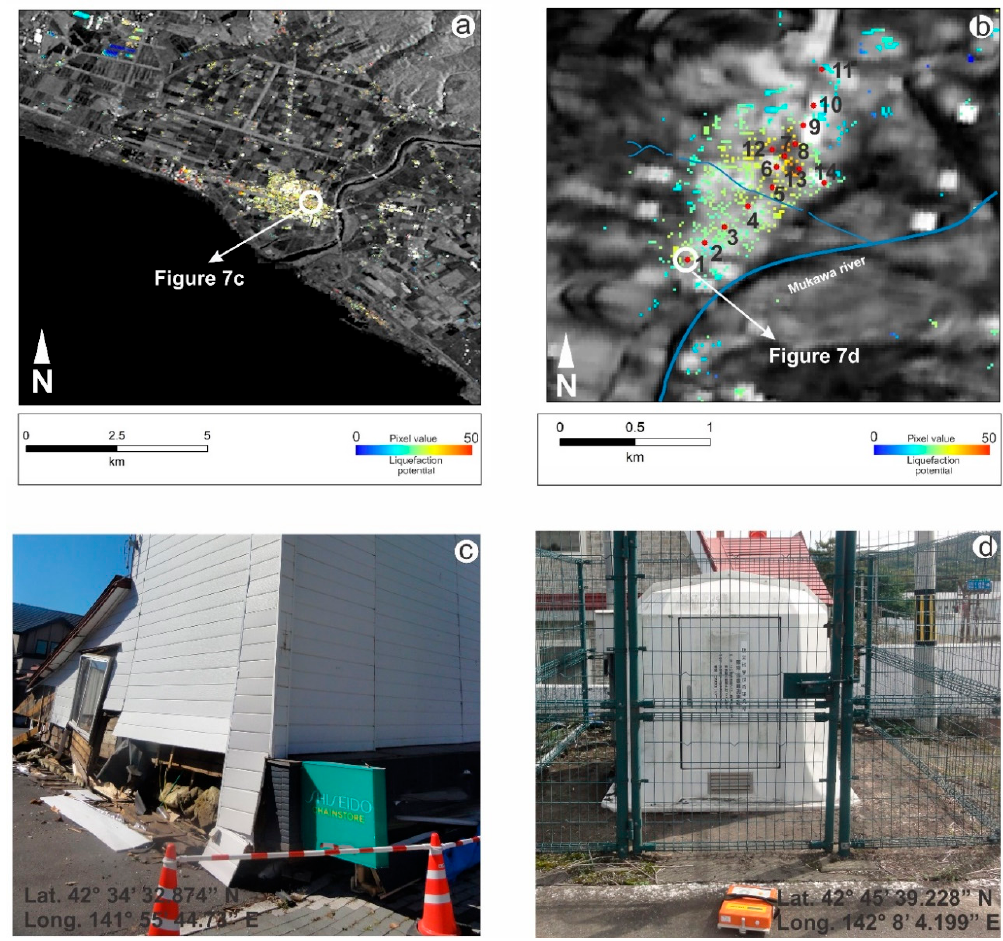
Figure 7. ( a ) WO map of Mukawa (track 18) overlain on the SAR intensity map (23 August 2018). ( b ) Hobetsu (track 18) overlain on the intensity map (23 August 2018). Red stars in Hobetsu are the locations of microtremor measurements, and white circles are the locations of the photographs taken: ( c ) example of damage to buildings in Mukawa; ( d ) microtremor measurement at point 1 in Hobetsu near the K-net seismic station.